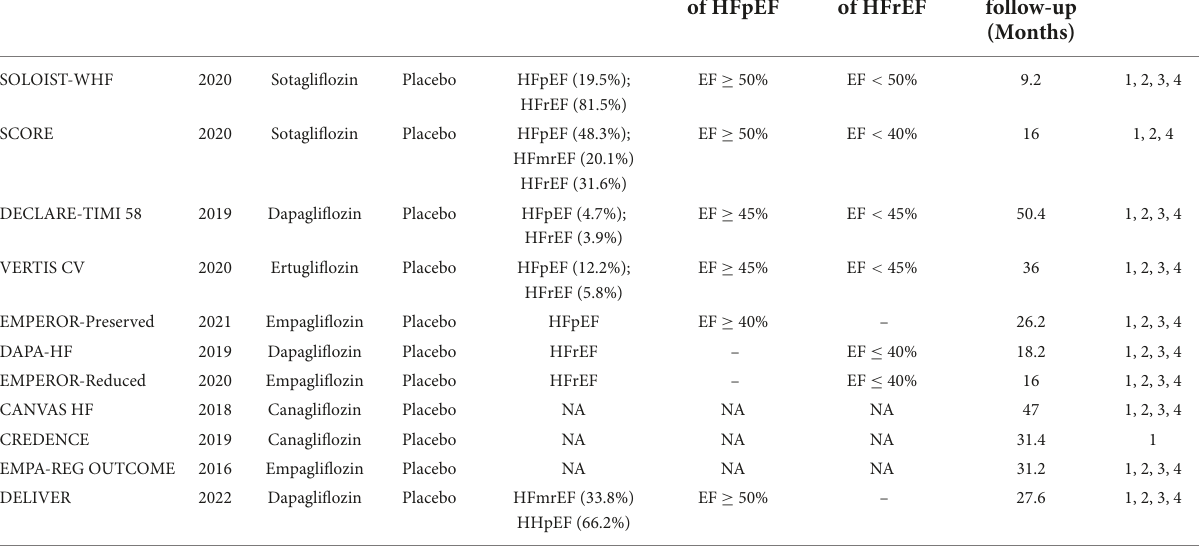
TABLE 1 The characteristic of included